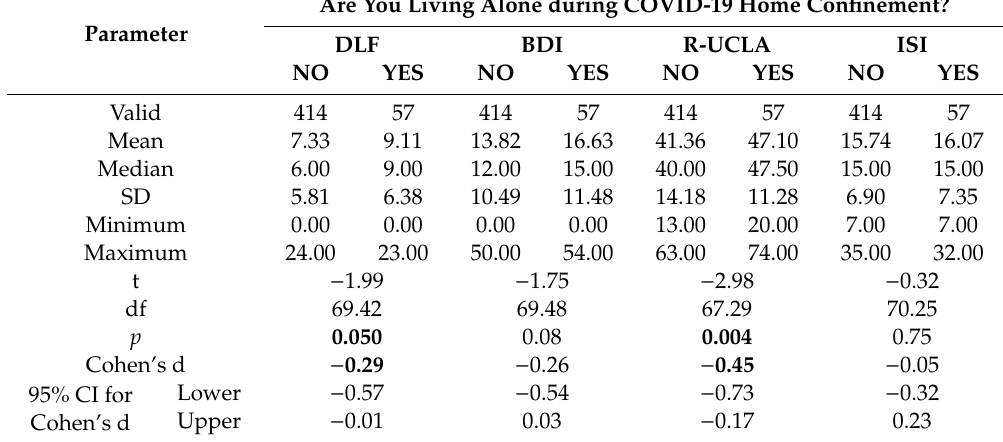
Table 5. Living alone (A) and new drug administration (B) during COVID-19 home confinement in terms of the Daily Life Fatigue scale (DLF), the Beck Depression Inventory (BDI), Revised UCLA Loneliness Scale (R-UCLA), and the Insomnia Severity Index (ISI) scales scores, n =